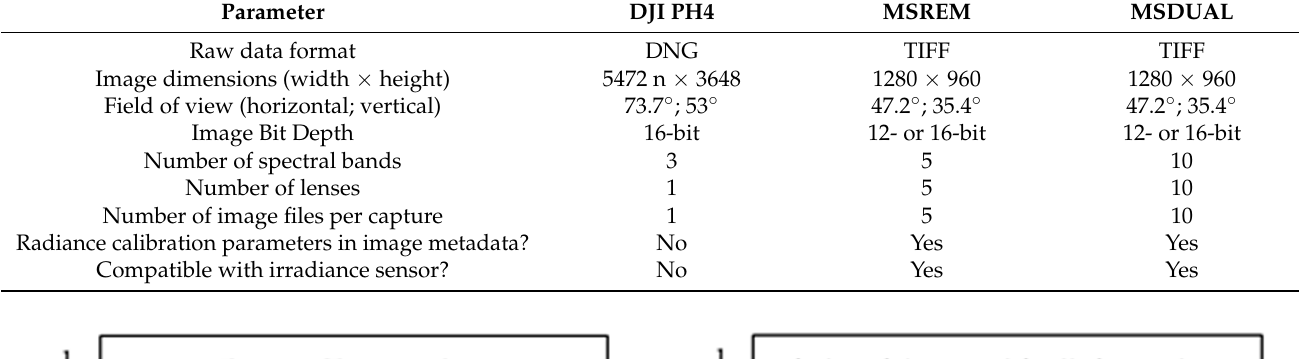
Table 1. Summary of three different camera systems used in this study.